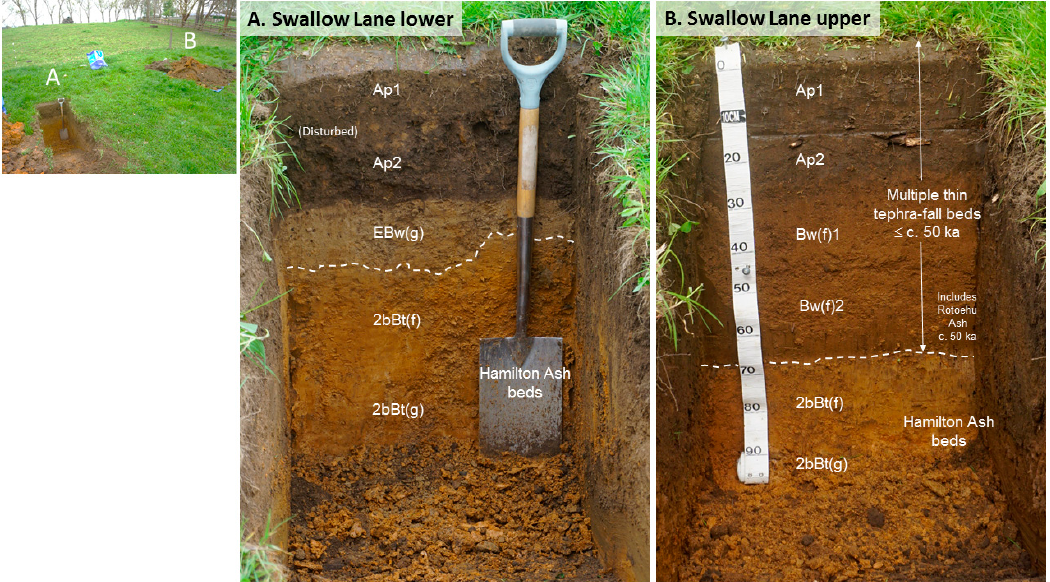
Figure 10. Two pits exposing the Kainui silt loam on a backslope position, elevations c. 54 and 55 m asl, on a low hill at Swallow Lane (37 ◦ 49 (cid:48) 23” S, 175 ◦ 22 (cid:48) 49” E) near Hamilton (Figure 1) in September, 2018. Mean annual rainfall here is c. 1200 mm/yr. In both pits the ‘A’ horizons have been overthickened. ( A ) Kainui soil with the lower part of the upper profile, the EBw(g) horizon, ‘caught in the act’ of having contemporary reducing conditions (gleying), the water perching above the clay-rich, relatively impermeable buried soil horizons on Hamilton Ash. The spade is c. 1 m high. ( B ) Kainui soil with a ‘normal’ oxidised profile, although the redox segregations in both Bw(f) horizons provide definitive evidence of periodic gleying taking place as can be seen in profile A. Redox segregations are formed as a result of the reduction and solubilisation of manganese or iron or both, their translocation and concentration and their re-oxidation and precipitation in the form of oxides [44,46] (Figure 9). Photos: D.J. Lowe.